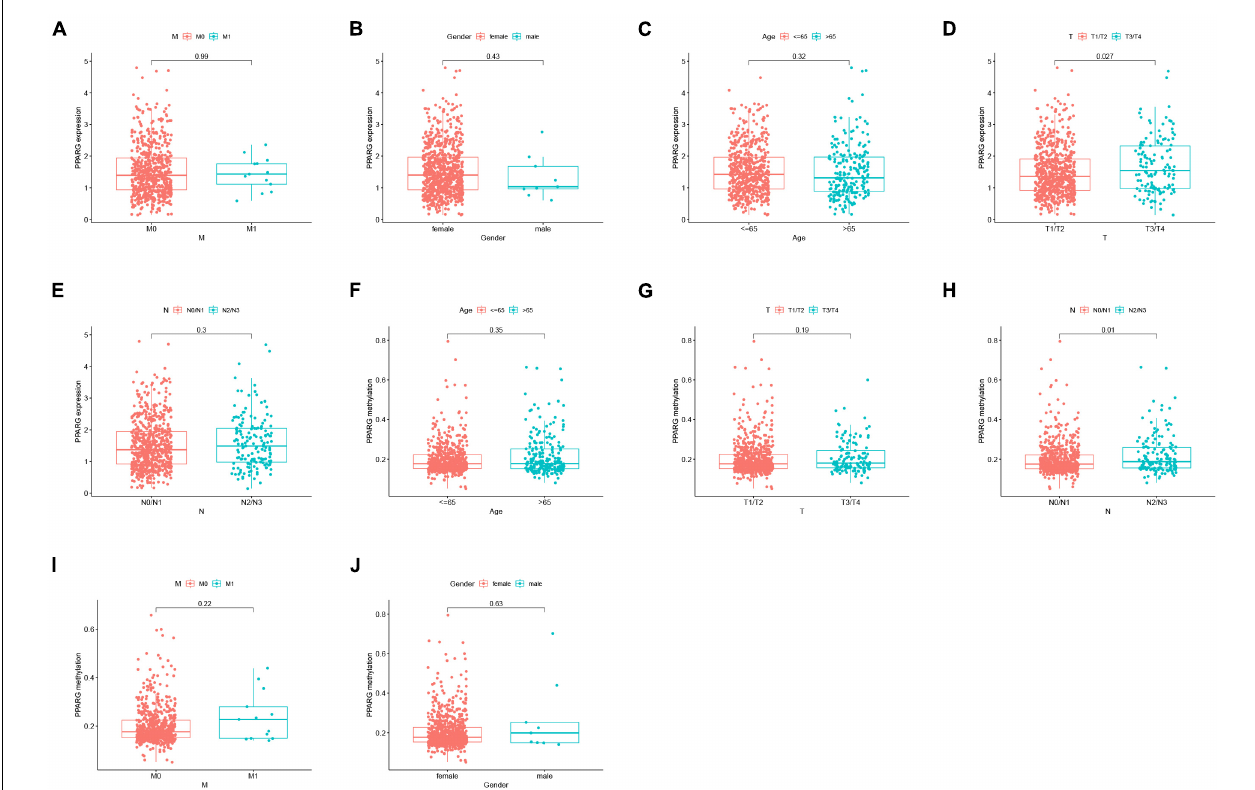
FIGURE 5 | Correlation analysis between PPARG and clinical. (A–E) Correlation analysis between PPARG mRNA expression level and clinical. (F–J) Correlation analysis between PPARG methylation level and clinical.